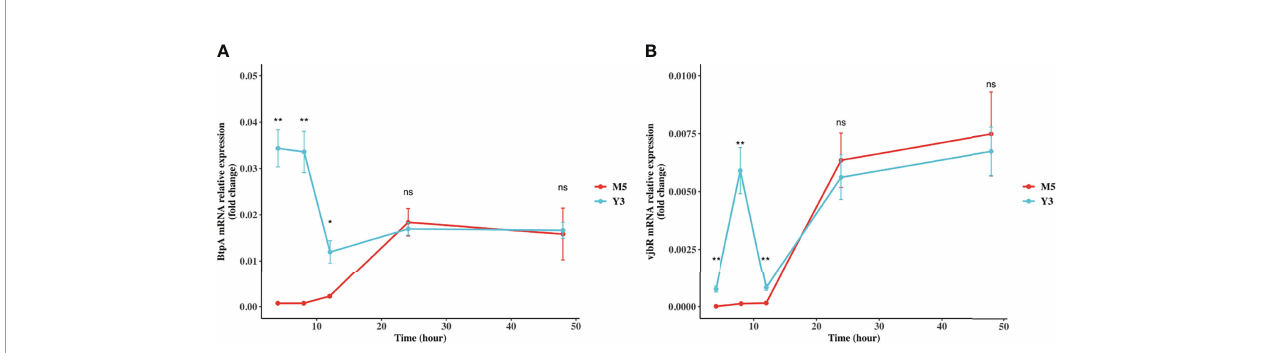
FIGURE 4 | Expression of BtpA and vjbR genes in RAW264.7 cells. RAW264.7 cell lines were infected with B. melitensis biovar 3 or B. melitensis M5-90 for 4, 8, 12, 24, 48 h. BtpA (A) and vjbR (B) gene expression were analyzed using real-time quantitative RT-PCR and normalized by the expression of 16 S